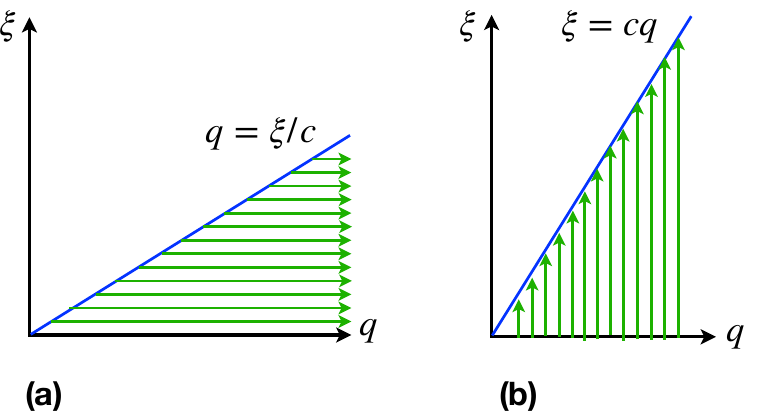
Figure 6. Integration order: ( a ) first with respect to q , then with respect to ξ ; ( b ) first with respect to ξ , then with respect to q